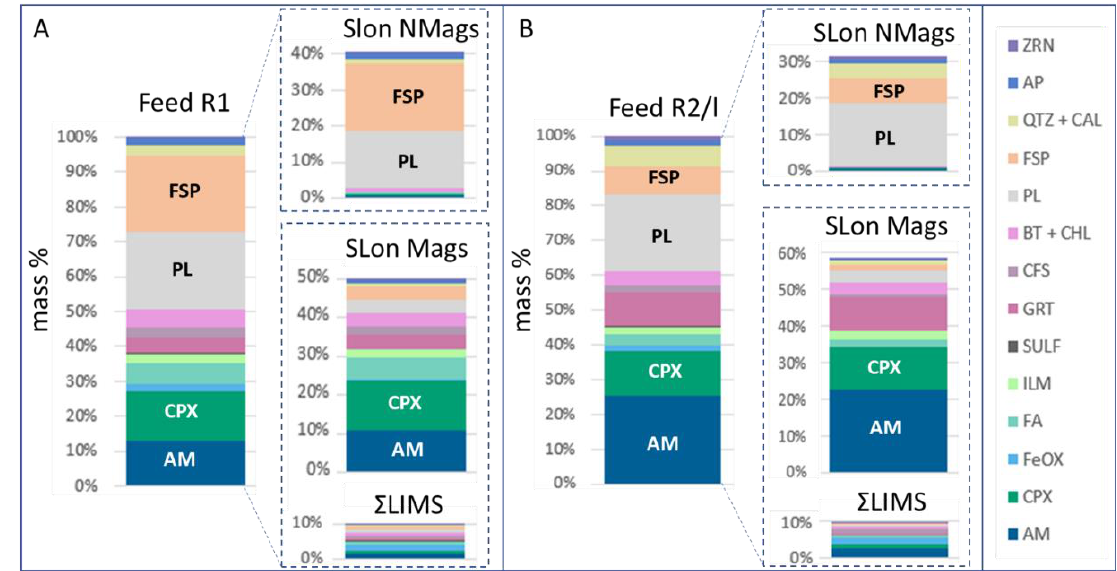
Figure 6. Modal mineralogy for feed, LIMS magnetic fractions, SLon magnetic fractions (SLon Mags) separated with 150 rpm and 1.0 T and corresponding tailings (SLon NMags) presented as mass% of the total material flow for ( A ) R1 and ( B ) R2/l composite samples. Mineral abbreviations: AM = amphibole; CPX = clinopyroxene; FeOX = magnetite; FA = fayalite; ILM = ilmenite; SULF = sulfides (both pyrrhotite and pyrite); GRT = garnet; CFS = clinoferrosilite; BT = biotite; CHL = chlorite; PL = plagioclase; FSP = potassium feldspar; QTZ = quartz; CAL = calcite; AP = apatite; ZRN = zircon.